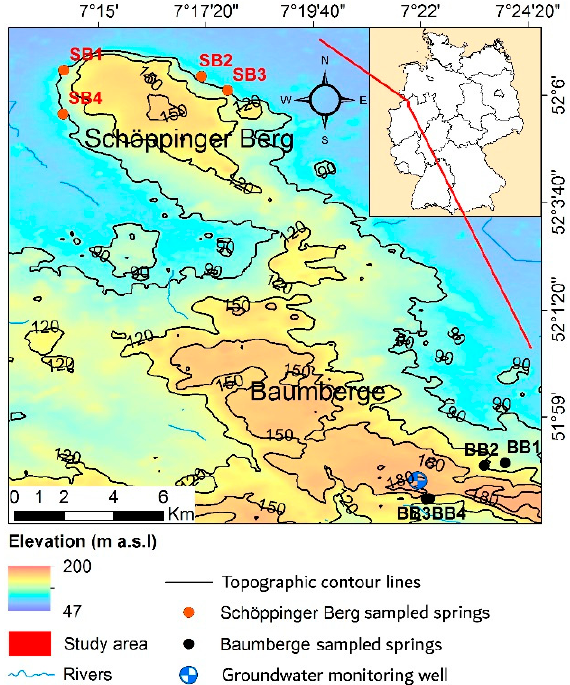
Figure 1. Upper right inset map shows Germany with border lines of its different states, and the study area as red rectangle. The main map shows the map of the study area with the location of eight sampling points/springs (black and red dots) in Baumberge and Schöppinger Berg, observation well (blue dot), main rivers and streams (blue lines), and contour lines, drawn on Shuttle Radar Topography Mission SRTM (PROCESSED SRTM DATA VERSION 4.1) digital elevation model (downloaded from CIAT-CSI SRTM website, on 20.08.2020).